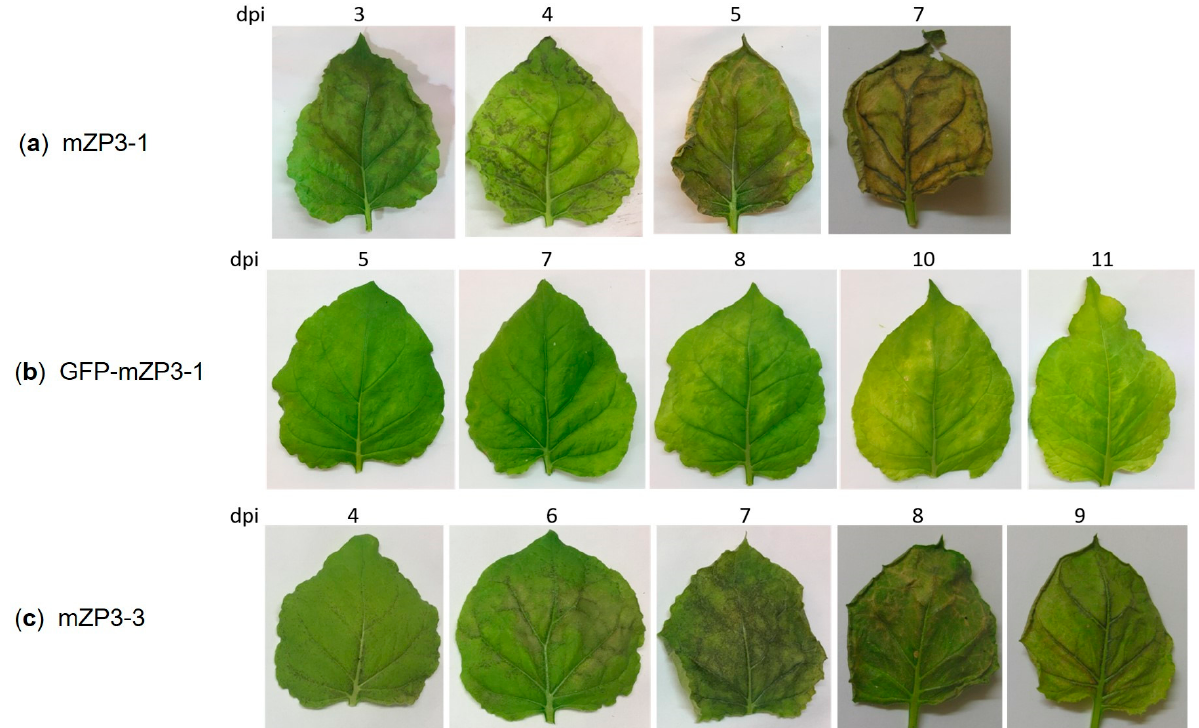
Figure 4. Morphological changes in N. benthamiana leaves agroinfiltrated with pICH31120 vector carrying mZP3-1 ( a ), GFP-mZP3-1 ( b ), or mZP3-3 ( c ) constructs. Protein expression induced chlorosis/necrosis and progressed to cell death on different days. Numbers represent days post-infiltration (dpi).